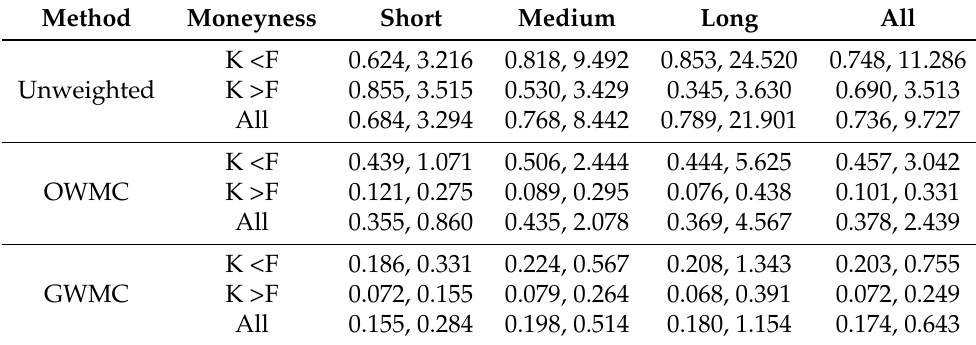
Table 2. Cross-sectional results for the unweighted version, the OWMC method, and the GWMC method using geometric Brownian motion as an initial model, for OTM puts (K <F) and OTM calls (K >F). The first and second numbers in each column are the MRPE and MAPE, respectively.